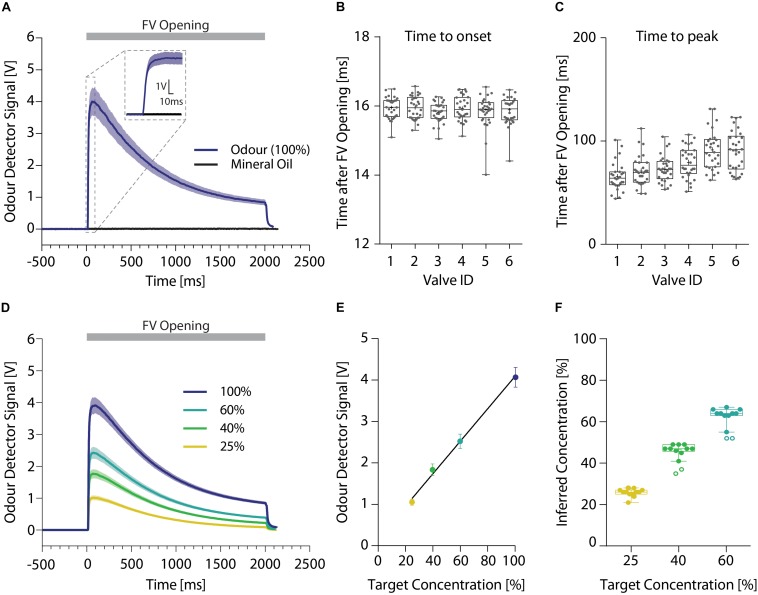
High resolution temporal analysis of different odor stimuli. (A) Representative signal obtained using an ionization detector for presentations of 2-butanone (dark blue; n = 12) or mineral oil (black; n = 10) without addition of any odors. Inset shows 20 ms prior and 100 ms after opening of the final valve in more detail. (B) Time until odor onset (defined as 10% of maximal odor concentration) and (C) peak odor concentration. (D) Representative odor pulse shapes for application of undiluted 2-butanone (dark blue) and applications of 60 (light blue), 40 (green), or 25% (yellow) 2-butanone dilutions directly generated using the olfactometer (n = 12 per dilution). (E) Correlation between the detected ionization intensity and the target odor dilution (n = 12 per dilution) (line denotes Pearson correlation coefficient). (F) Relationship of the intended target odor concentration and the inferred odor concentrations, extrapolated from the measured odor detector signal (n = 12 per dilution). (A)/(D): Time relative to opening of the final valve. Line and shaded areas denote mean ± SEM. (B)/(C)/(F): Whiskers show 1.5 interquartile range, line denotes median while cross denotes mean and circles represent potential outliers as identified by ROUT test.